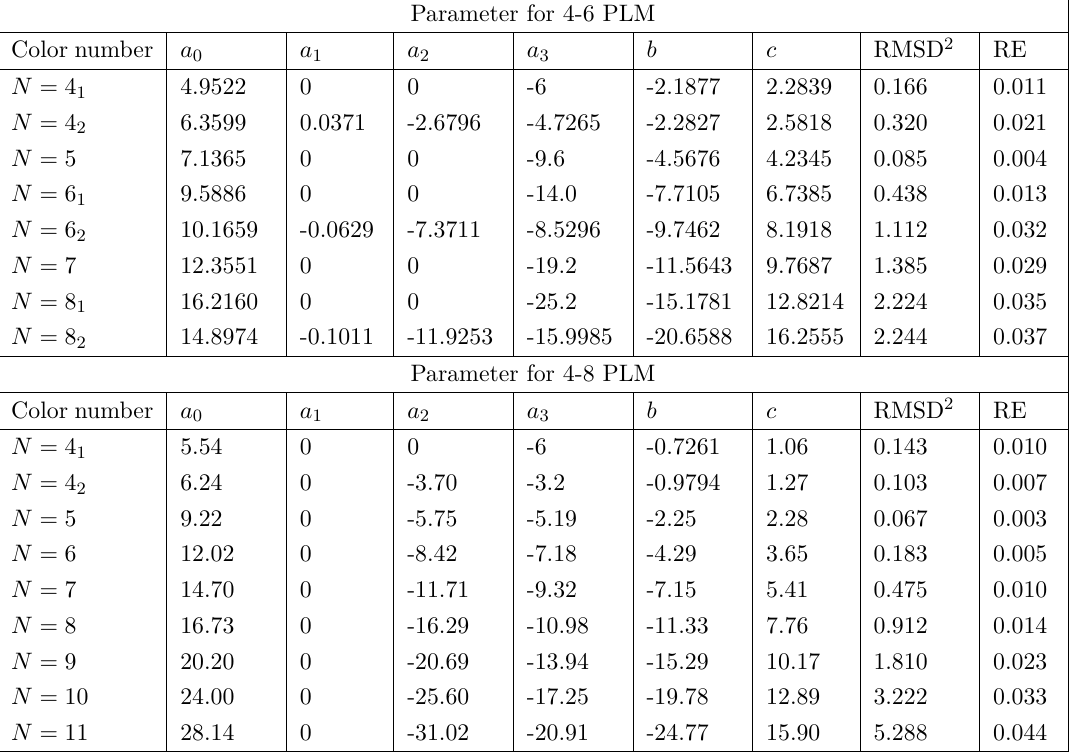
Table 1 . The fitting parameters for the 4-6 and 4-8 PLMs. The two groups on the list for the cases with N = 4 , 6 , 8 separate two categories: one is the case where only a is used as the 3 fitting parameter (corresponding to N ), and the other case treats all a , and a as the fitting 1 1 , a 2 3 parameters ( N ). The n denotes the number of data and the LS fits for the N = 4 PLMs have been 2 performed based on the data for T ≤ 1 . 2 T . As to the cases with N = 5 and N ≥ 7 , which are c directly unavailable from [22], the prospected data have been read off by using the large N scaling from N = 4 or 6 data, as noted in the text, and the fitting has been done by using the method √ described in the text. Though their RMSDs ( = LS / n ) are relatively poorer, the relative